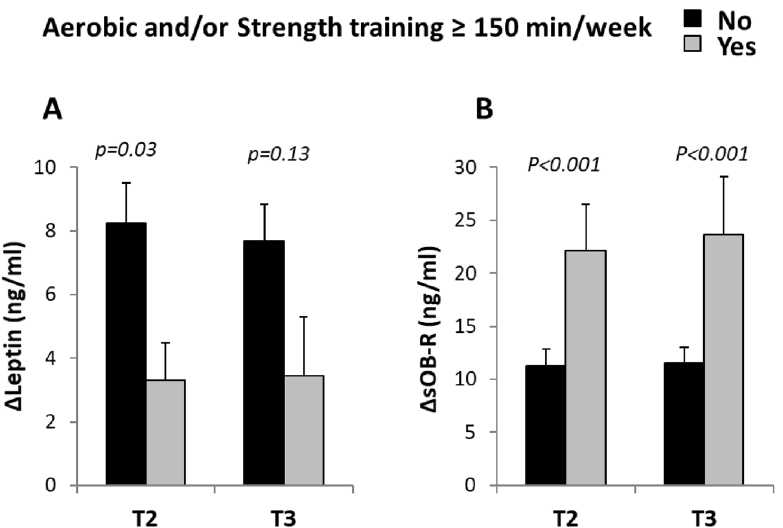
Figure 4. Gestational change in leptin and sOB-R in women of normal weight depending on whether they reached 150 min aerobic and/or resistance training or not. Changes (T1 to T3) in A) leptin and B) sOB-R depending on whether the women reported a minimum of 150 min aerobic and/or resistance training during pregnancy (in T2 and T3). Significance determined with ANCOVA adjusted for age, BMI in trimester 1, parity and